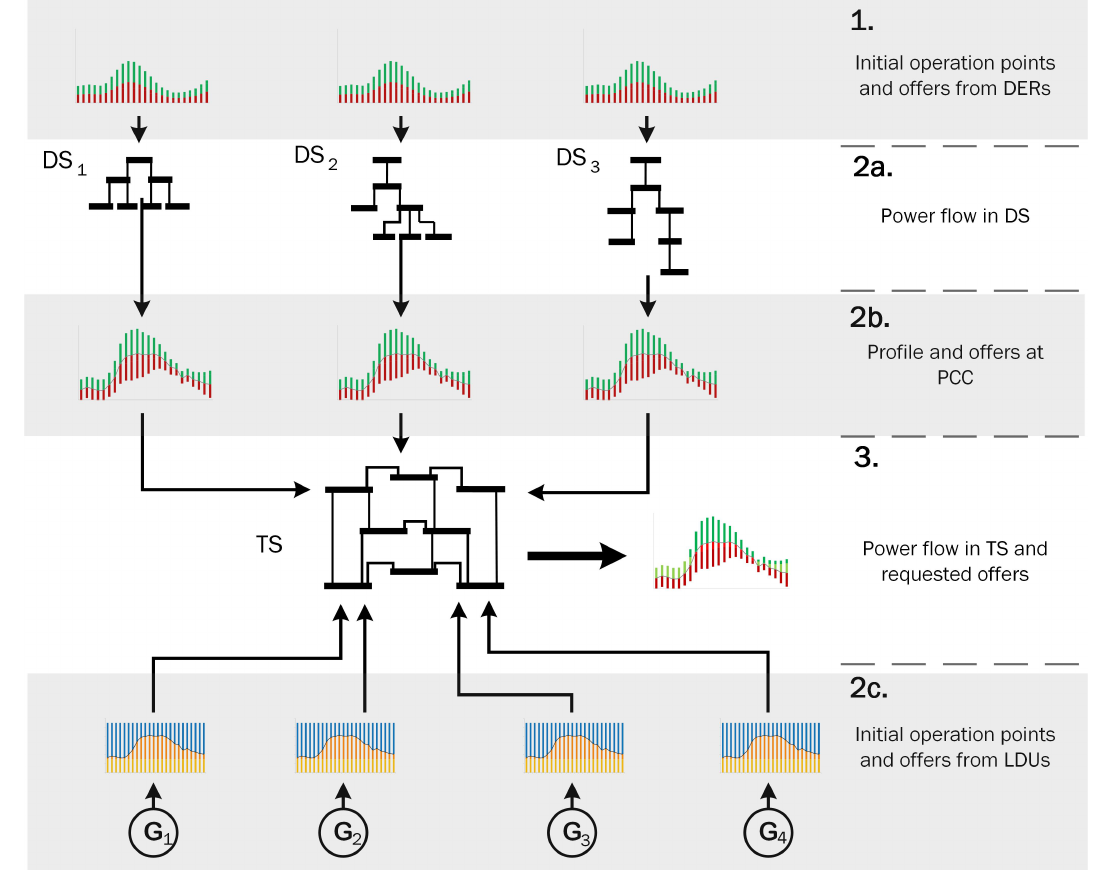
Figure 3. Scheme of the first, second and third phases in TSO–DSO coordination in